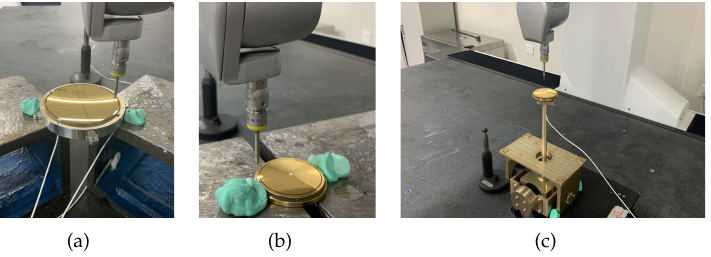
Figure 14. Altitude datum measurement operations: ( a ) h 1 measurement; ( b ) h 2 measurement; ( c ) h 3 measurement.